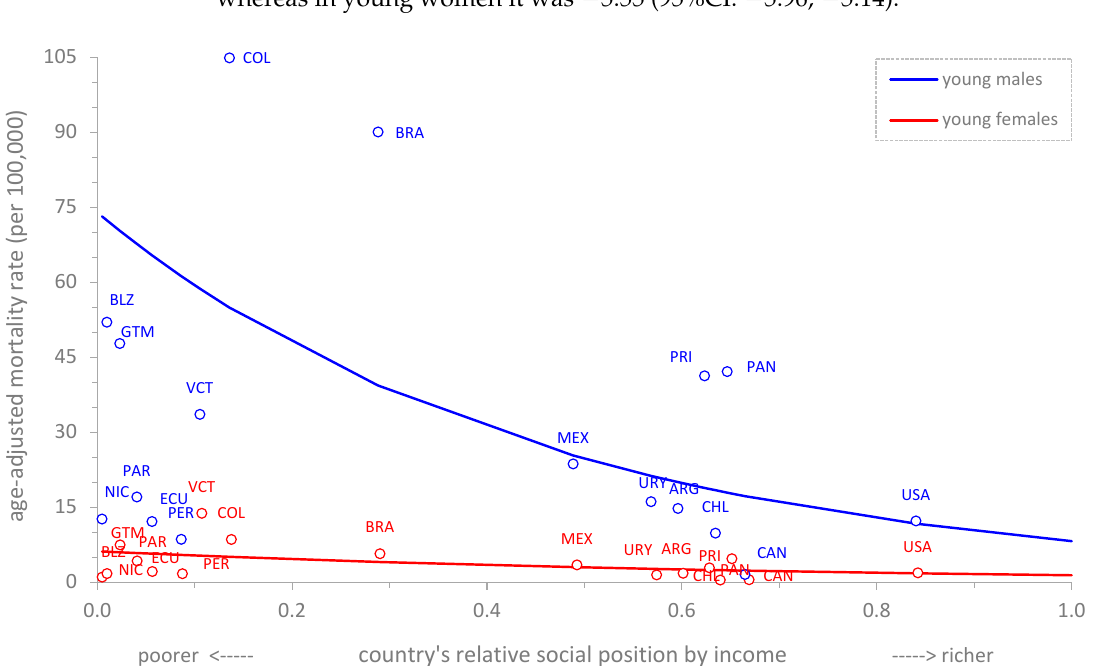
Figure 2. Cross-country income-related inequality gradients in mortality due to homicide in young (10–24 years old) males and females. Region of the Americas, 2015.